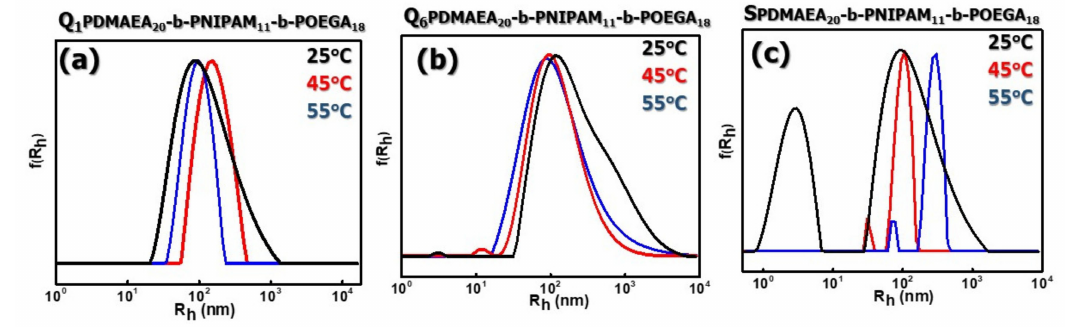
Figure 7. Hydrodynamic radius distributions for Q 1 PDMAEA 20 -b-PNIPAM 11 -b-POEGA 18 ( a